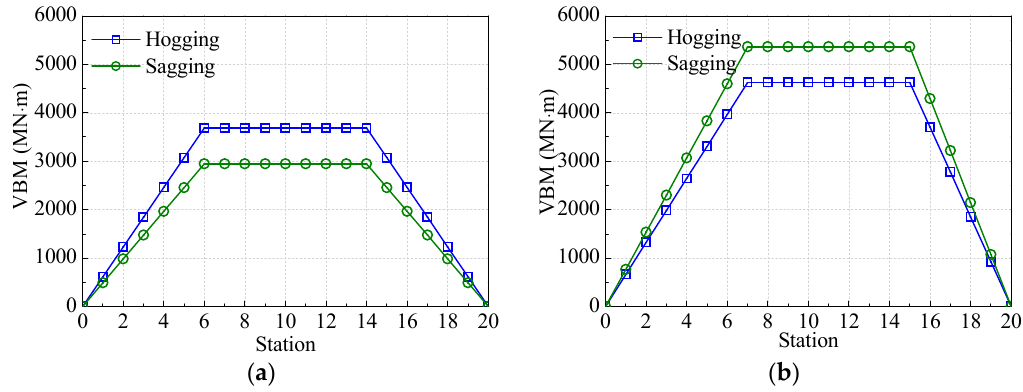
Figure 21. Distribution of design loads of VBM. ( a ) Still water VBM; ( b ) wave-induced VBM.